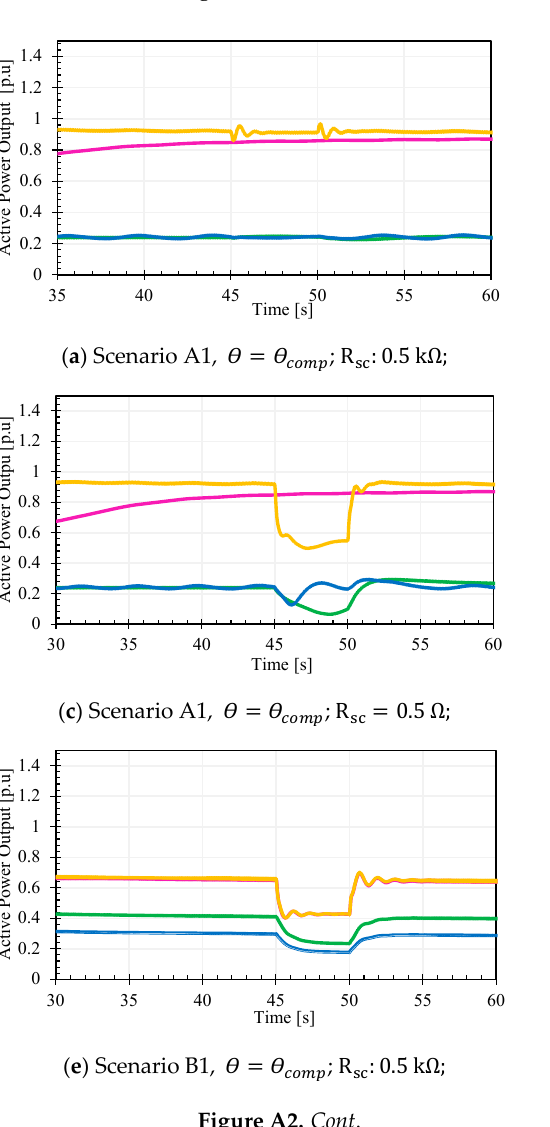
Figure A1. Load and RES active power with SCR = 10. The graphs in Figure A2 represent the load and RES active power in the case of a weak grid (SCR = 3).